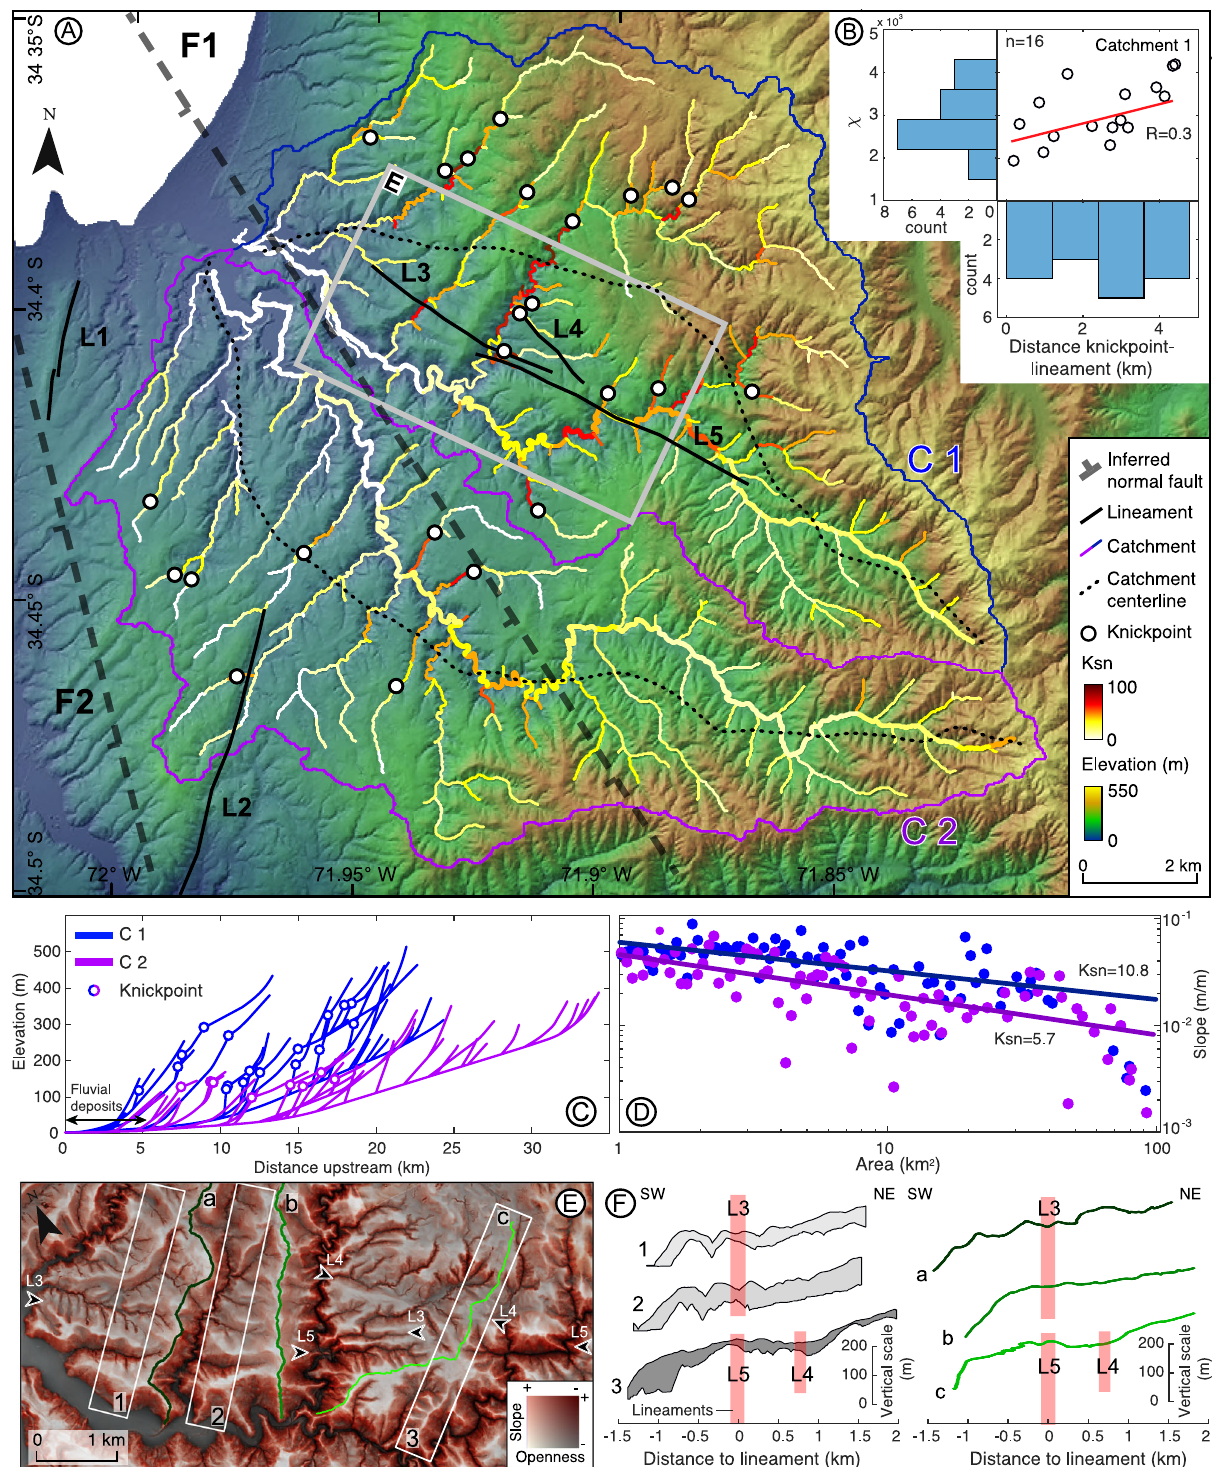
Fig. 2 On-fault tectonic geomorphology from bare-earth LiDAR topography. A Shaded-relief map of the PIF coastal reach showing the two analysed catchments (C1 and C2), the thick dashed black lines are the faults (F1 and F2) inferred from spatial alignments of crustal seismicity. Note asymmetry of the main trunk streams with respect to the catchment centreline. The black lines labelled L1 to L5 denote lineaments that may represent surface-breaching faults (see text for discussion). Steepness index (K sn ) determined for a reference concavity of 0.45. B Scatter plots and histograms comparing fl uvial metrics with the lineament metrics within C1. Scatter plot and histograms of chi-values ( χ ) at knickpoints with respect to distance to lineament (See chi- map Fig. S2A). C Longitudinal river pro fi les of both catchments showing knickpoint locations. D Slope-area plots for both catchments. Note that C1 has a higher K sn value suggesting more rapid uplift. E Red-relief map of lineaments, ridge pro fi les (green lines) and swath boxes (black rectangles) shown in F . The arrows indicate the trace of the lineaments. F Swath and ridge-crest pro fi les. Pro fi les 1, 2, a, and b are centred on the trace of lineament L3, and pro fi les 3 and c are centred on the trace of L5. Note the lack of evident scarps suggesting an absence of any recent surface-breaching